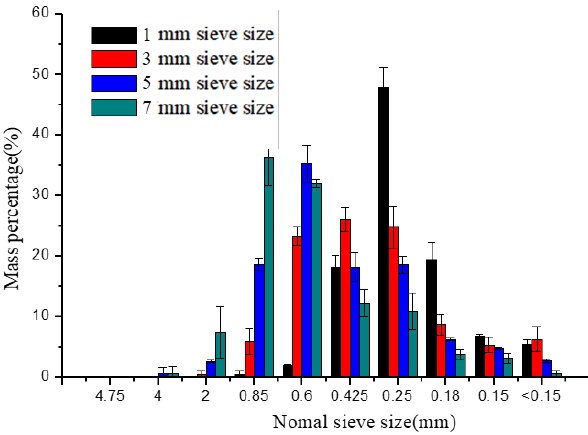
Figure 3. Particle size distribution of different sieve sizes.